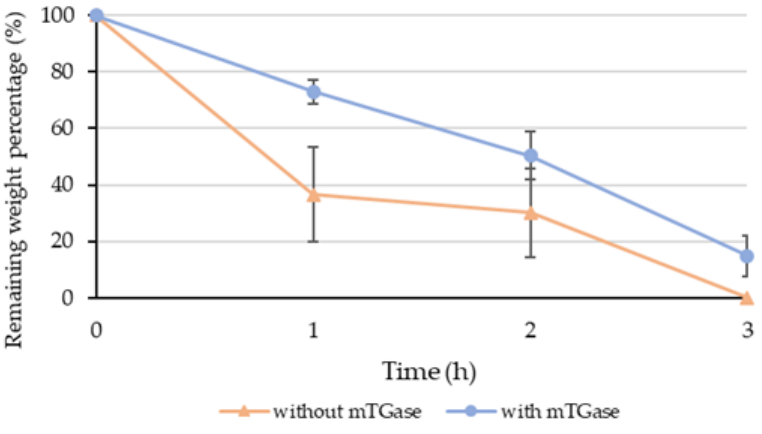
Figure 4. Enzymatic degradation of GelMA gels with or without mTGase treatment (mTGase: microbial transglutaminase).